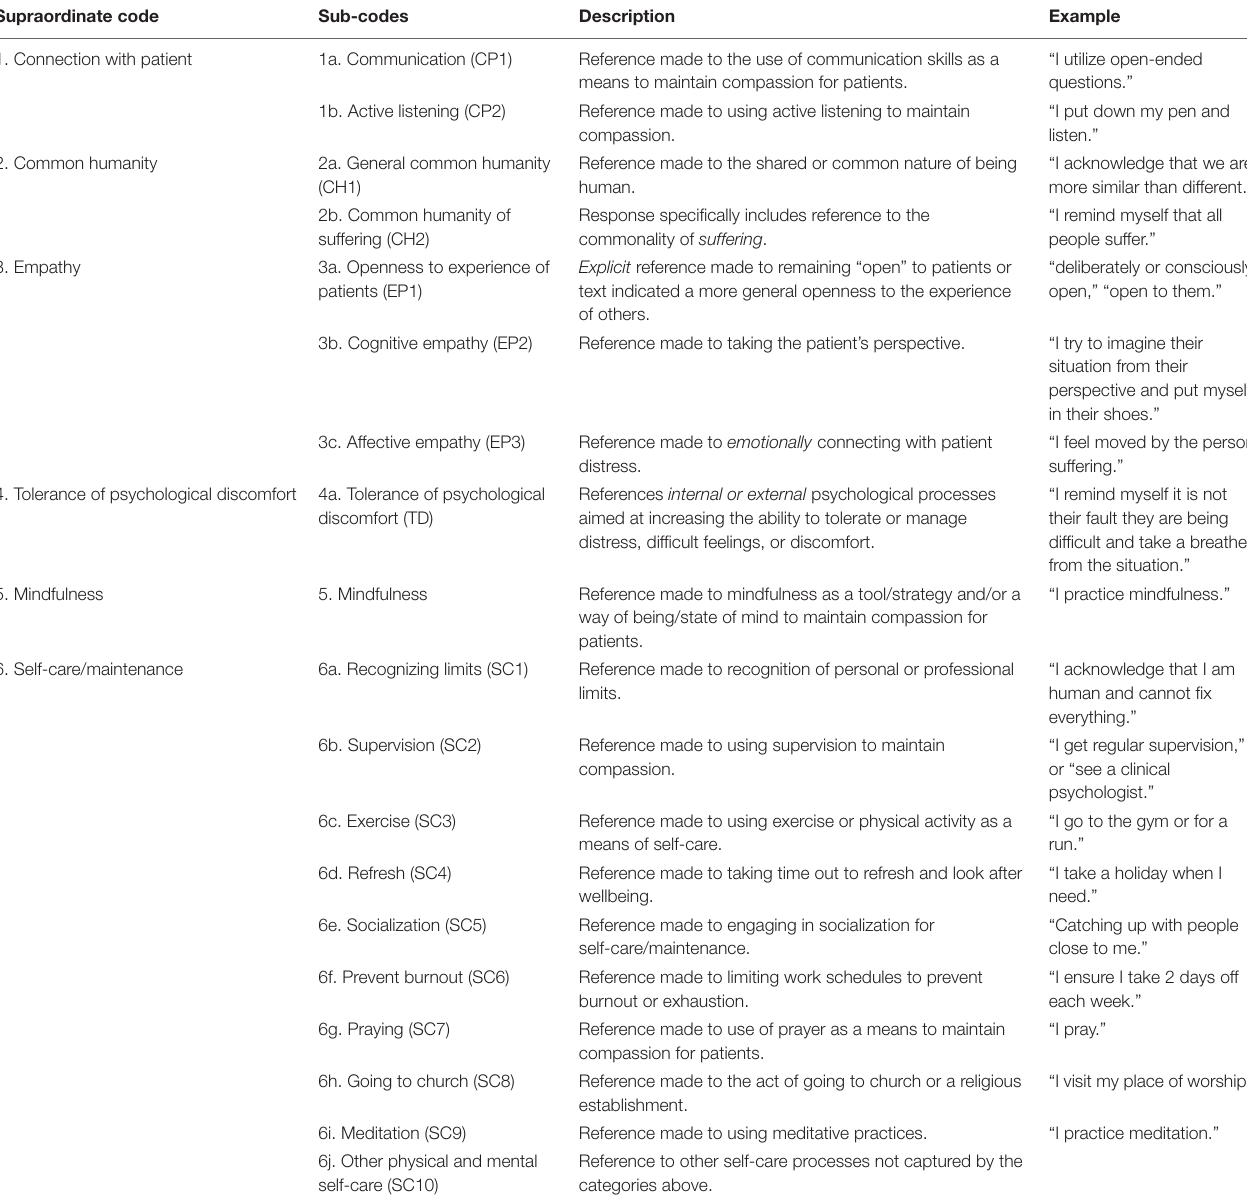
TABLE 2 | Final coding system used to score self-reported compassion maintaining strategies in healthcare